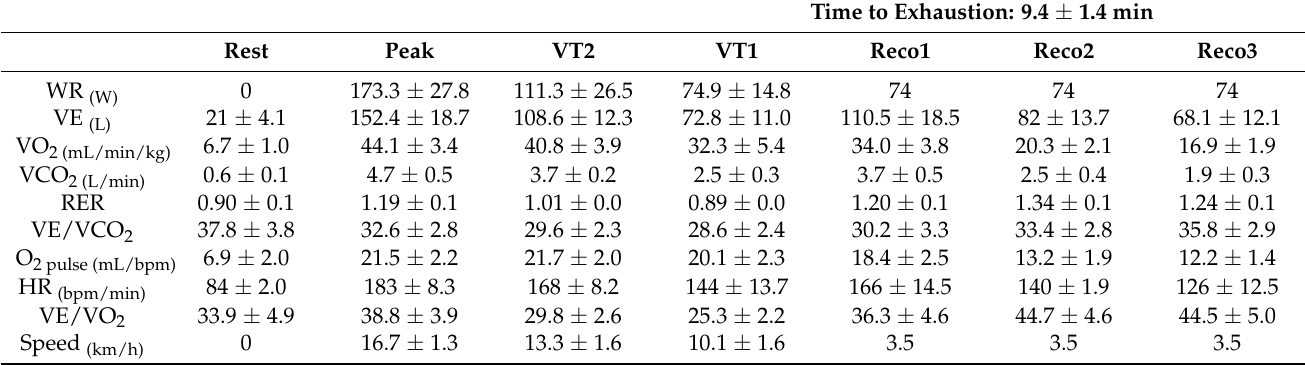
Table 3. Characteristics